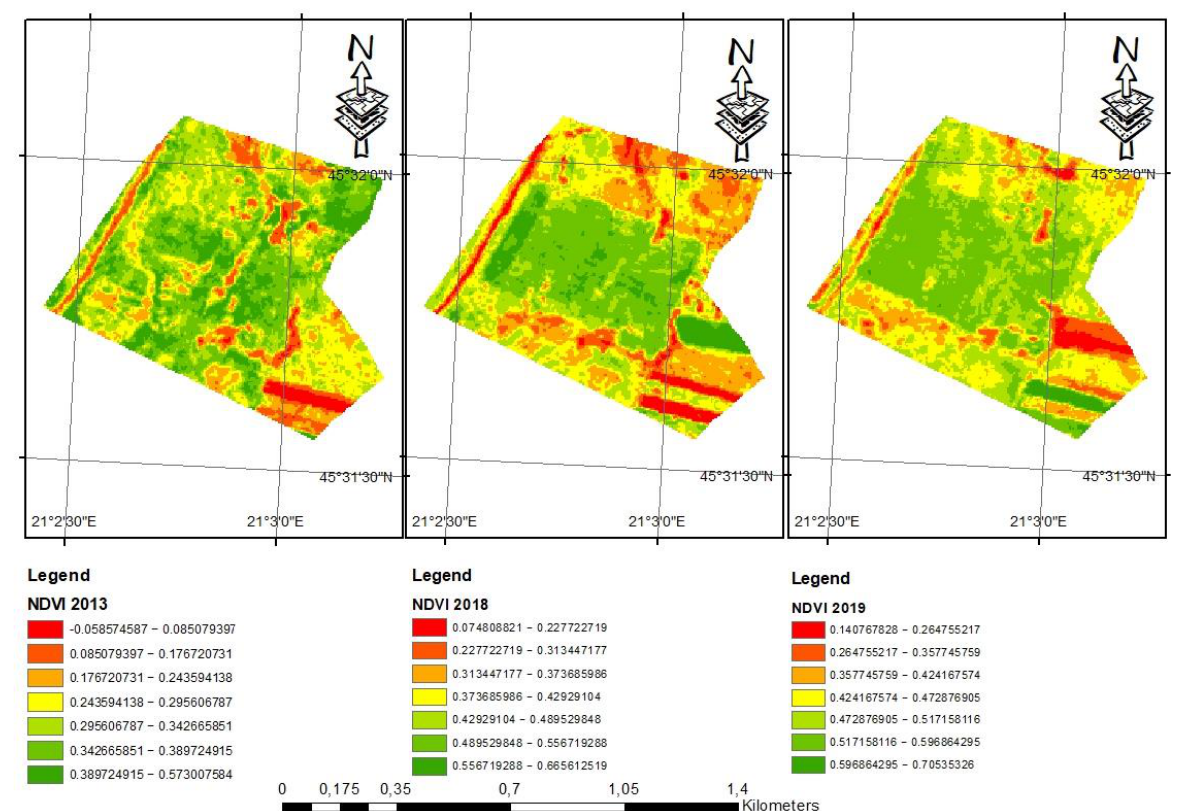
Figure 6. NDVI map for plot P816, pasture category, under the influence of pig sludge.